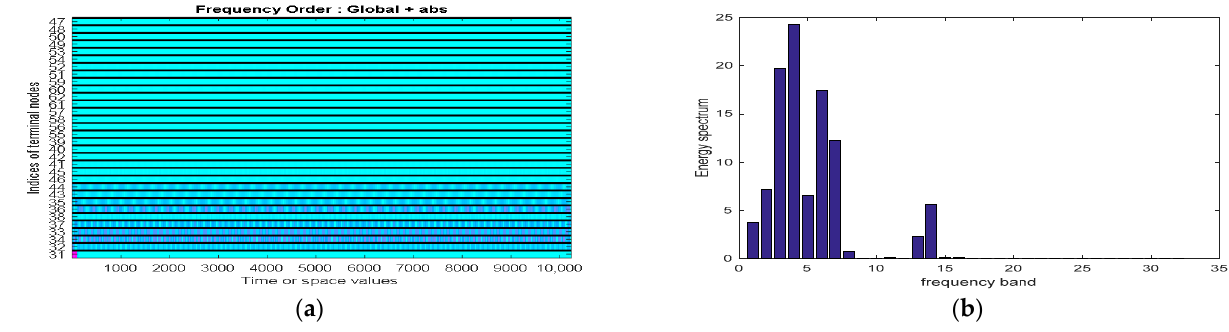
Figure 5. ( a ) db5 wavelet tree termination node; ( b ) energy spectrum of db5 wavelet decomposition.